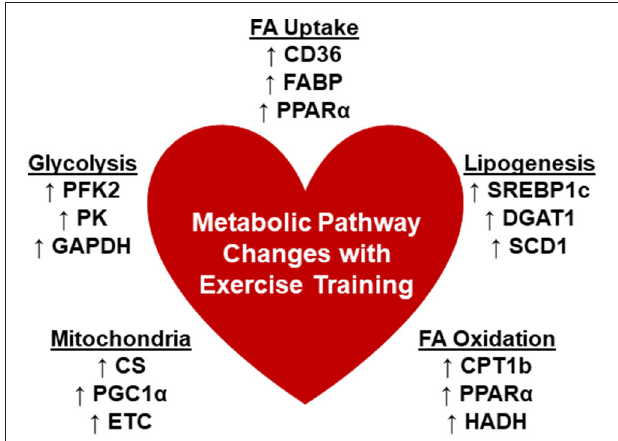
FIGURE 1 | Changes in cardiometabolic pathways with chronic exercise trainingx. There are limited reports that detailed the changes that occur in the metabolic pathways associated with myocardial substrate utilization. Summarized are the reported changes in enzymes or genes that are involved in the processes: Fatty acid (FA) uptake, lipogenesis, FA oxidation, mitochondrial function, and glycolysis. CD36, cluster of differentiation 36; CS, citrate synthase; CPT1b, carnitine palmitoyltransferase 1b; DGAT1, diacylglycerol acyltransferase 1; ETC, electron transport chain; FABP, fatty acid binding protein; GAPDH, glyceraldehyde 3-phosphate dehydrogenase; HADH, hydroxyacyl-coenzyme A dehydrogenase; PPAR α , peroxisome proliferator-activated receptor, alpha; PGC1 α , peroxisome proliferator-activated receptor gamma coactivator 1-alpha; PFK2, phosphofructokinase 2; PK, pyruvate kinase; PFK; SCD1, stearoyl CoA desaturase 1; SREBP1c, sterol regulatory element-binding protein 1c.